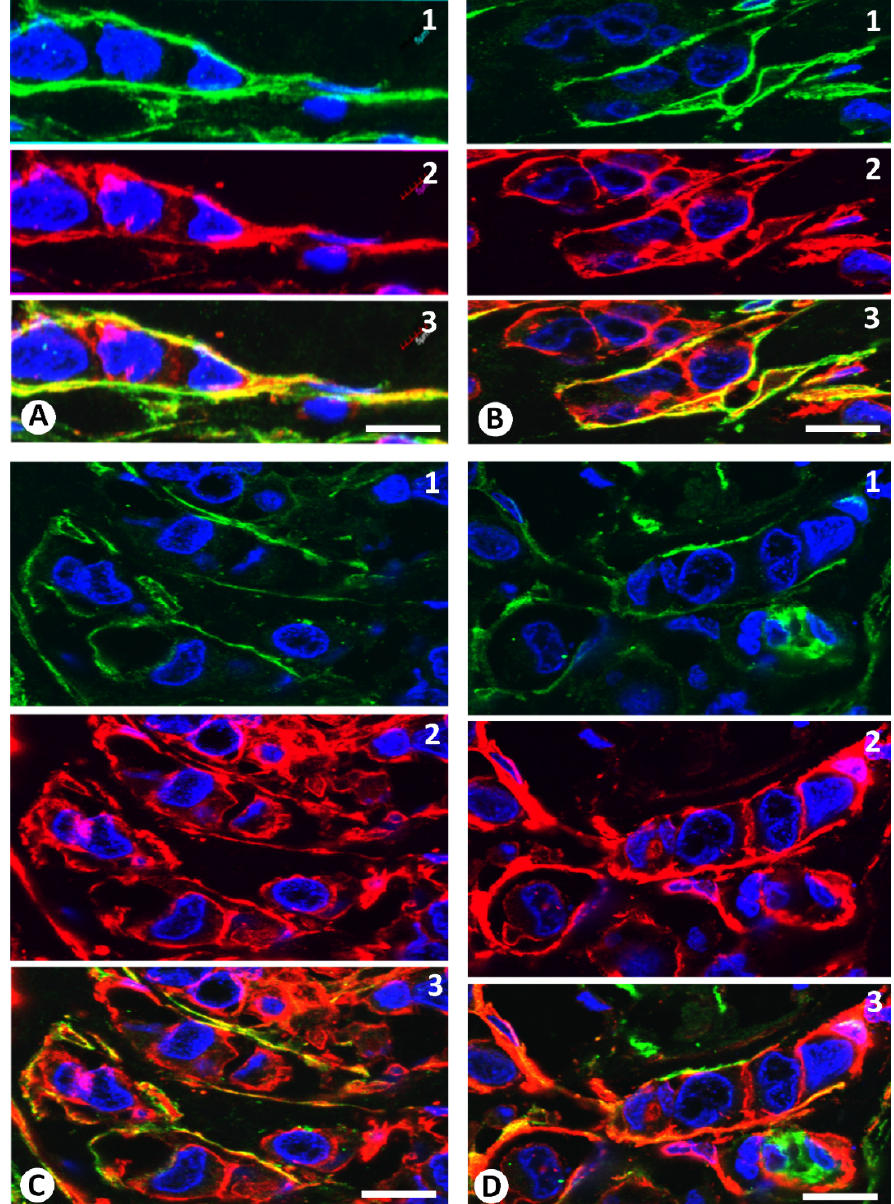
Figure 9. Double immunofluorescence labelling for CD34 (green) and α SMA (red) with DAPI (blue) counterstain. Coexpression of CD34 and α SMA is observed in stromal cells around neoplastic cells. Note cells expressing CD34 (green, ( A ) 1 , ( B ) 1 , ( C ) 1 and ( D ) 1 ), α SMA (red, ( A ) 2 , ( B ) 2 , ( C ) 2 and ( D ) 2 ) and both markers merged (yellow, ( A ) 3 , ( B ) 3 , ( C ) 3 and ( D ) 3 ). Bar: ( A , B , D ): 10 µm; ( C ): 20 µ